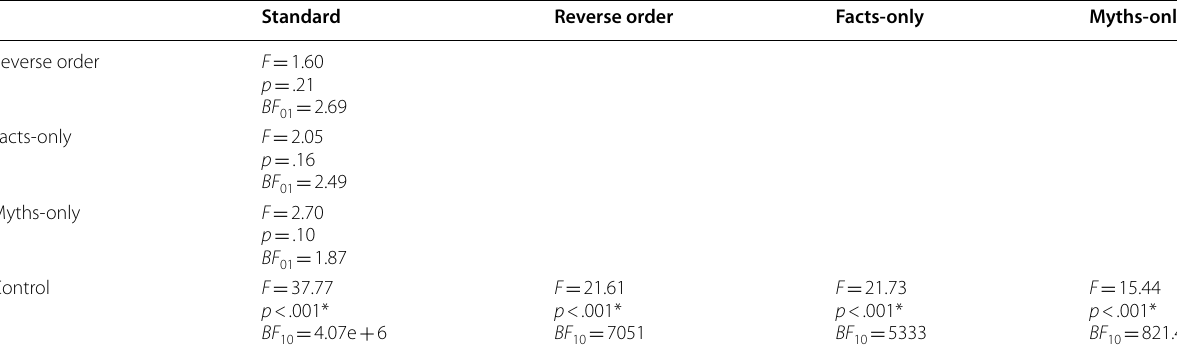
Table 4 Planned comparisons on myth inference scores in Experiment